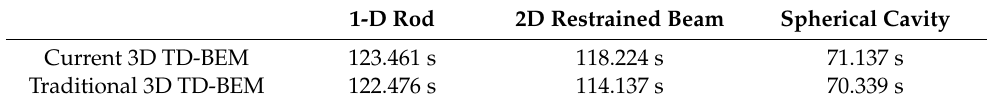
Table 4. Time cost of the current 3D TD-BEM and the traditional 3D TD-BEM in the three